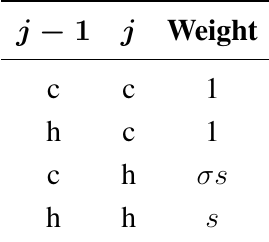
Table 1. Summary of the ZB weights for two residues that are adjacent to each other in a